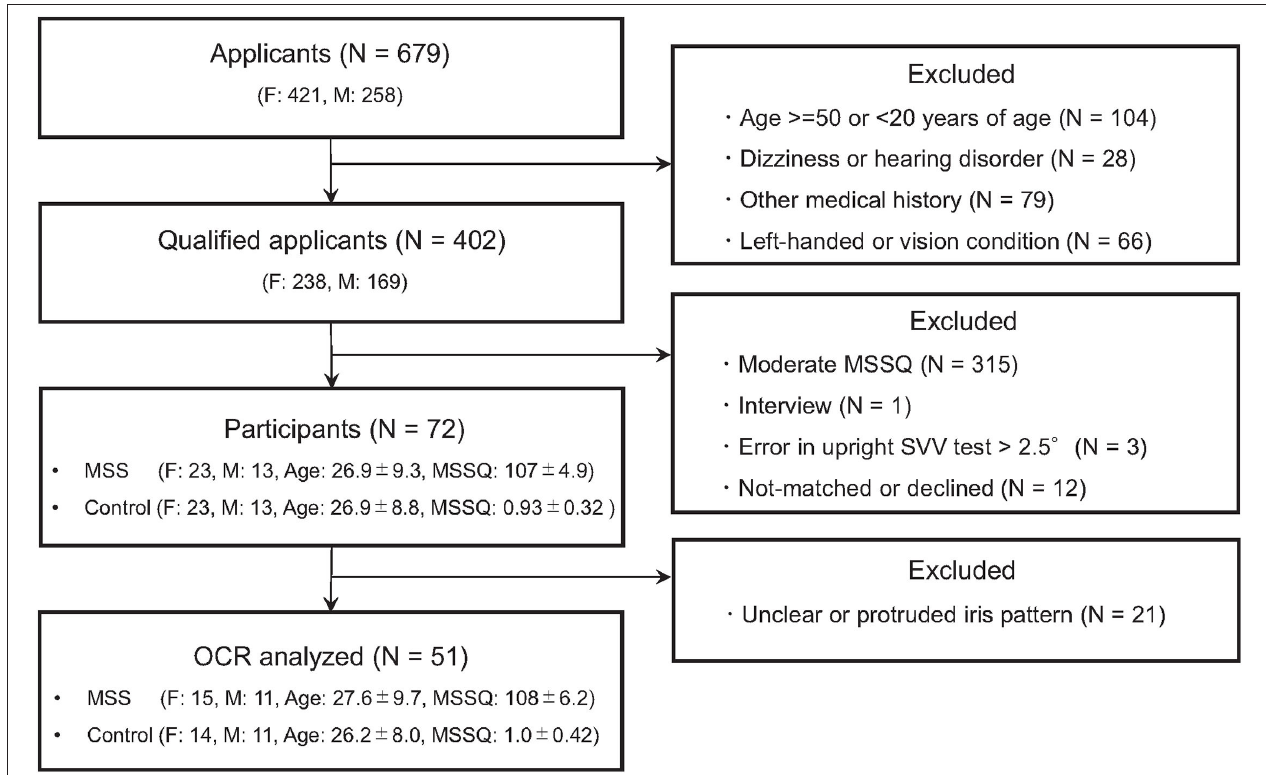
FIGURE 1 | Flowchart of the screening process. N, F, and M denote numbers of group, female and male participants, respectively. Age and MSSQ denote means ± SEM of age and Motion Sickness Susceptibility Questionnaire (MSSQ) score,